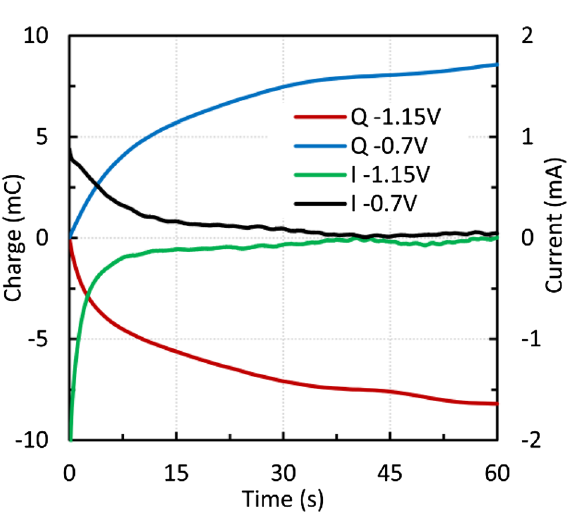
Figure 10. Micromagnetite—chronocoulometric curves after 7 voltammetric cycles at 10 mV s −1